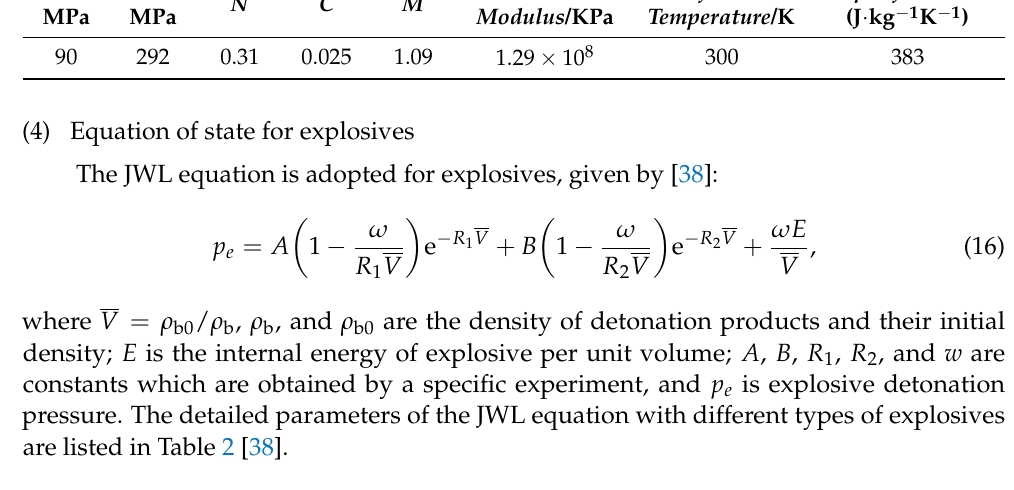
Table 2. Parameters of the JWL equation of different types of explosives